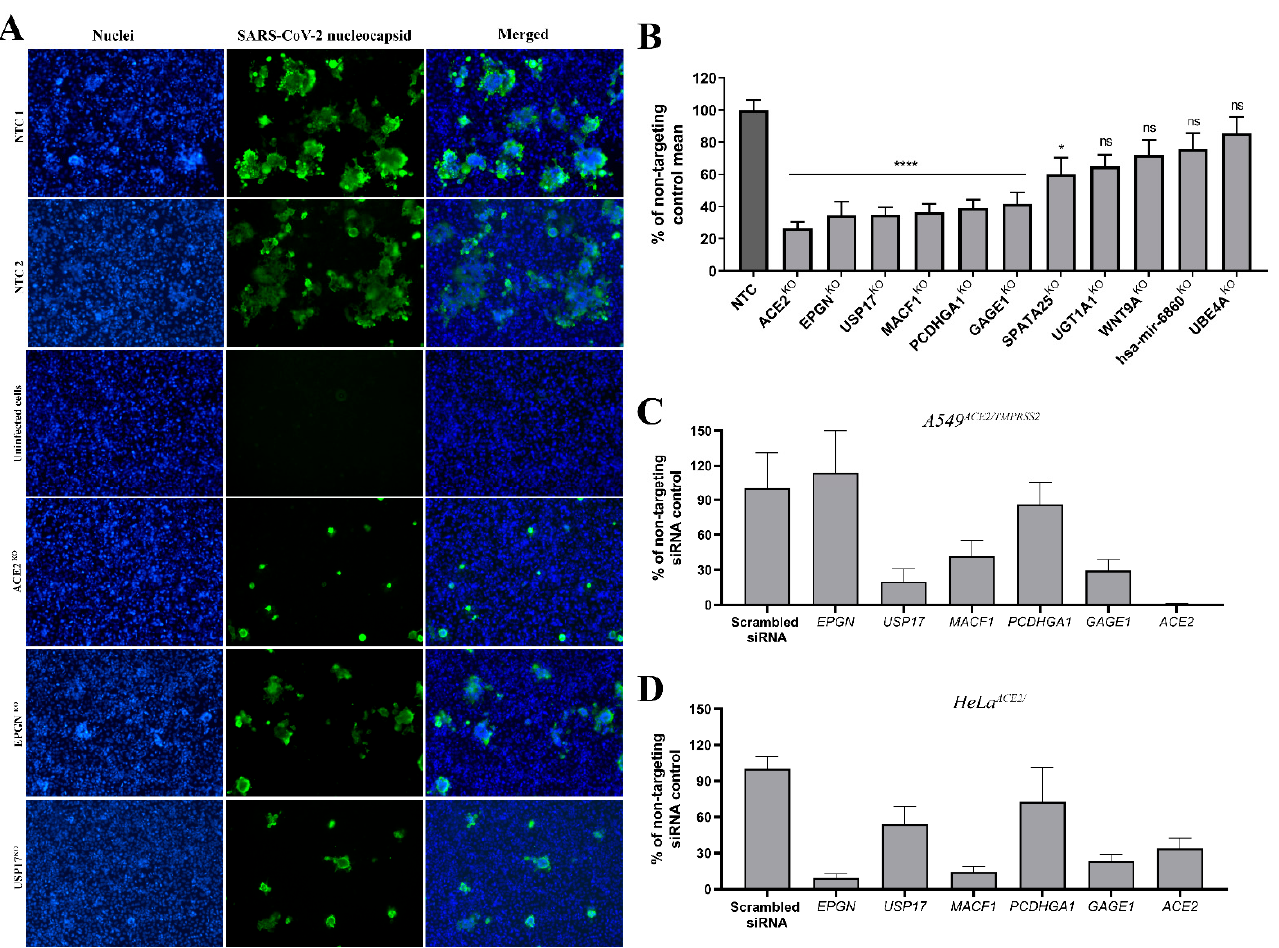
Figure 4. Identification of essential factors for SARS-CoV-2 replication in modified HeLa ACE2 and A549 ACE2/TMPRSS2 cells. ( A ) Immunostaining assay was performed as described in Section 2; cells were fixed after 24 hours pi. Blue color denotes nuclei, green SARS-CoV-2 nucleocapsid protein. ( B ) SARS-CoV-2 replication was evaluated in modified HeLa ACE2 cells transduced with vectors harboring the template for sgRNA knockouts of ACE2, EPGN, USP17, MACF1, PCDHGA1, GAGE1, SPATA25, UGT1A1, WTN9A , hsa-mir-6860 , and UBE4A genes. Two sgRNAs non-targeting any sequence in the genome were used as a control (NTC). Inhibition of viral infection was assessed 48 hours pi. by RT-qPCR, data were normalized and presented as percentage of the non-targeting control mean. Data are presented as a mean ± SEM from three independent experiments, each performed in triplicate or quadruplicate. Data were analyzed with Shapiro–Wilk and Brown-Forsythe tests. To determine the significance of differences between compared means, one-way ANOVA with post hoc Dunnett’s test was used. Values statistically significant are indicated by asterisks: * p < 0.05, **** p < 0.0001, ns—non-significant. SARS-CoV-2 replication was evaluated in modified A549 ACE2/TMPRSS2 ( C ) and HeLa ACE2 ( D ) cells transfected with siRNA targeting ACE2, EPGN, USP17, MACF1, PCDHGA1 , and GAGE1 genes. Non-targeting siRNA was used as a control (NTC). Inhibition of viral infection was assessed 48 hpi by RT-qPCR, data were normalized and presented as percentage of the non-targeting siRNA control. Data are presented as a mean ± SEM from three independent experiments, each performed in triplicate or quadruplicate.